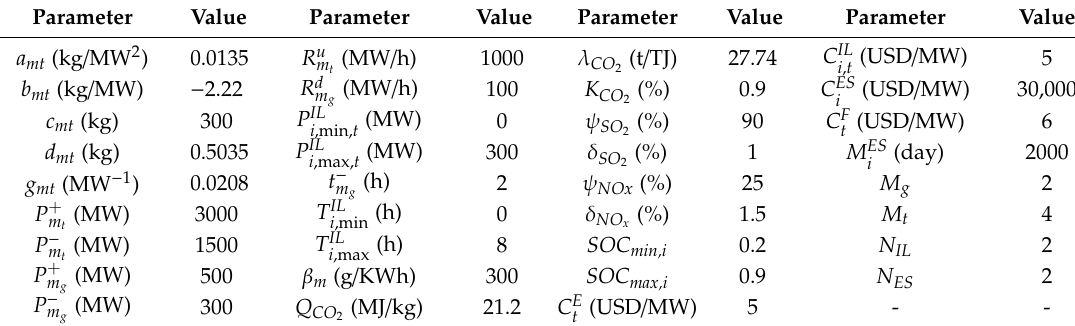
Table 2. The parameters of dispatch models.